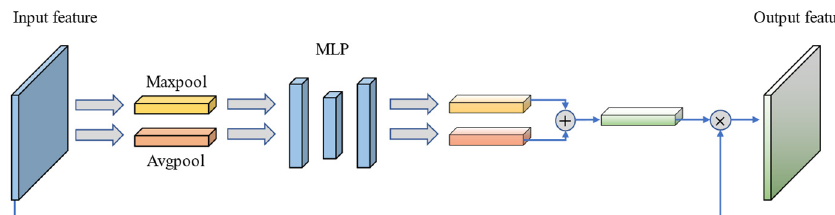
Figure 4. Illustration of the KAM.